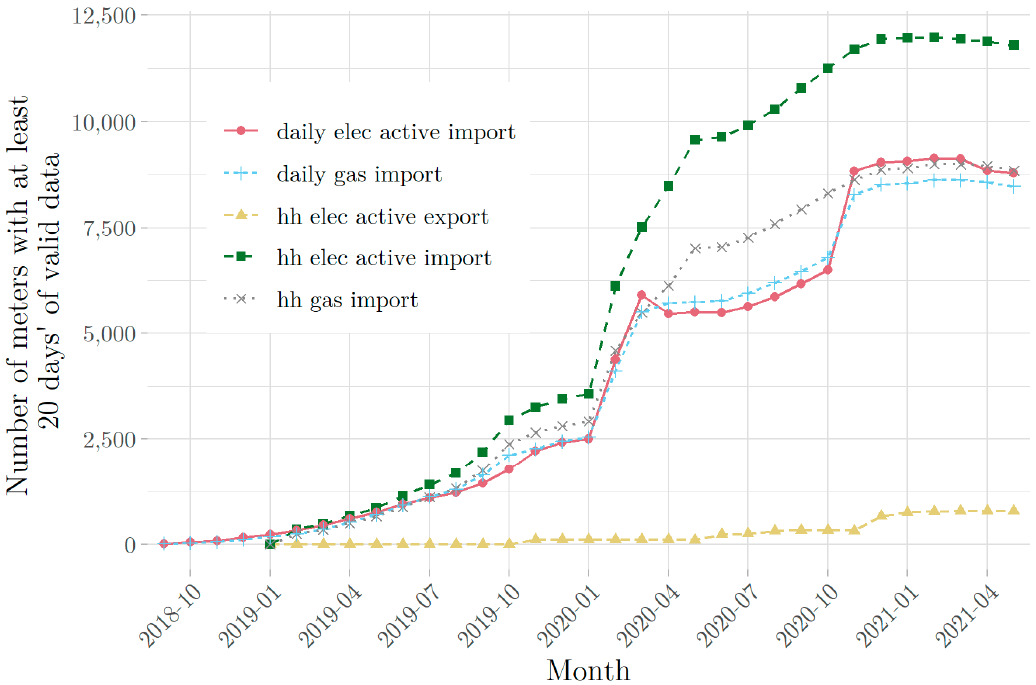
Figure 4. Number of meters with at least 20 daily reads (or 20 days’ worth of half-hourly reads) available, recorded at the correct time, and flagged as ‘valid’ each month.